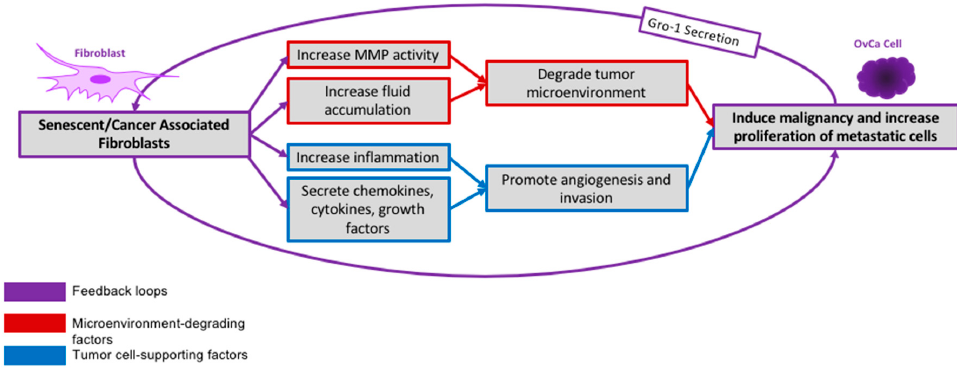
Figure 3. Stromal-Epithelial Crosstalk. Active crosstalk occurs between senescent and activated fibroblasts and OvCa cells. This induces activated fibroblasts, while concurrently inducing proliferation and malignancy of the invading